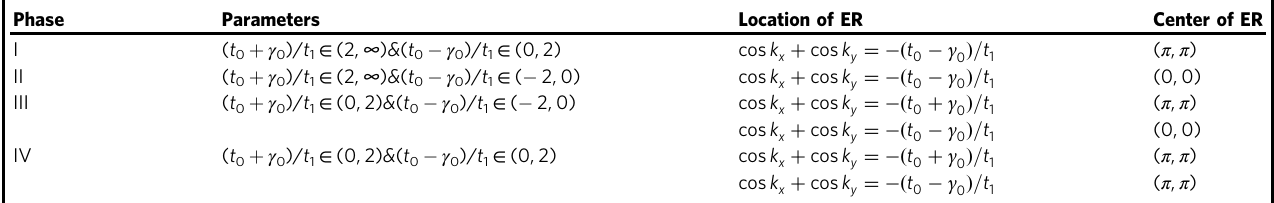
¼ ± ± t = 0.75, γ t = 0.5. 0 / 1 0 / 1